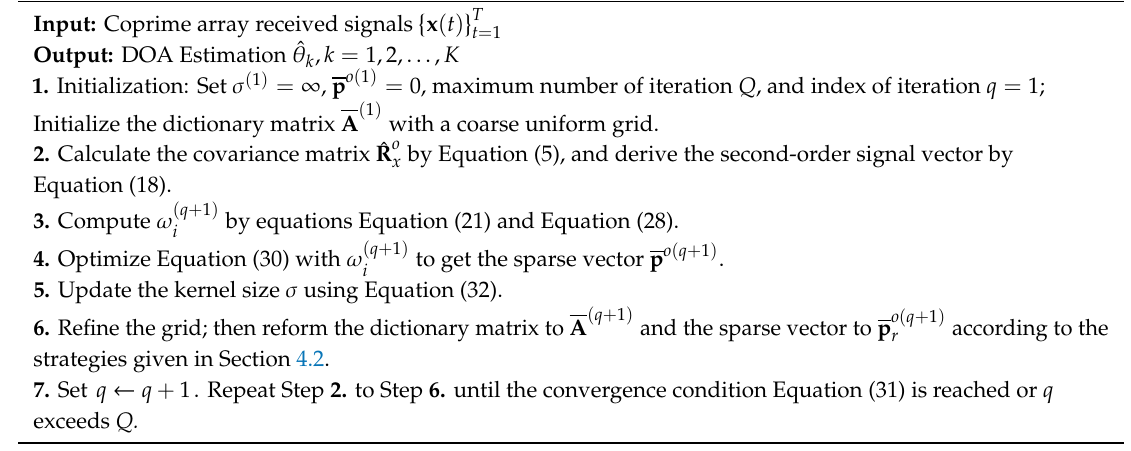
Algorithm 1. The proposed coprime array-based robust DOA estimation